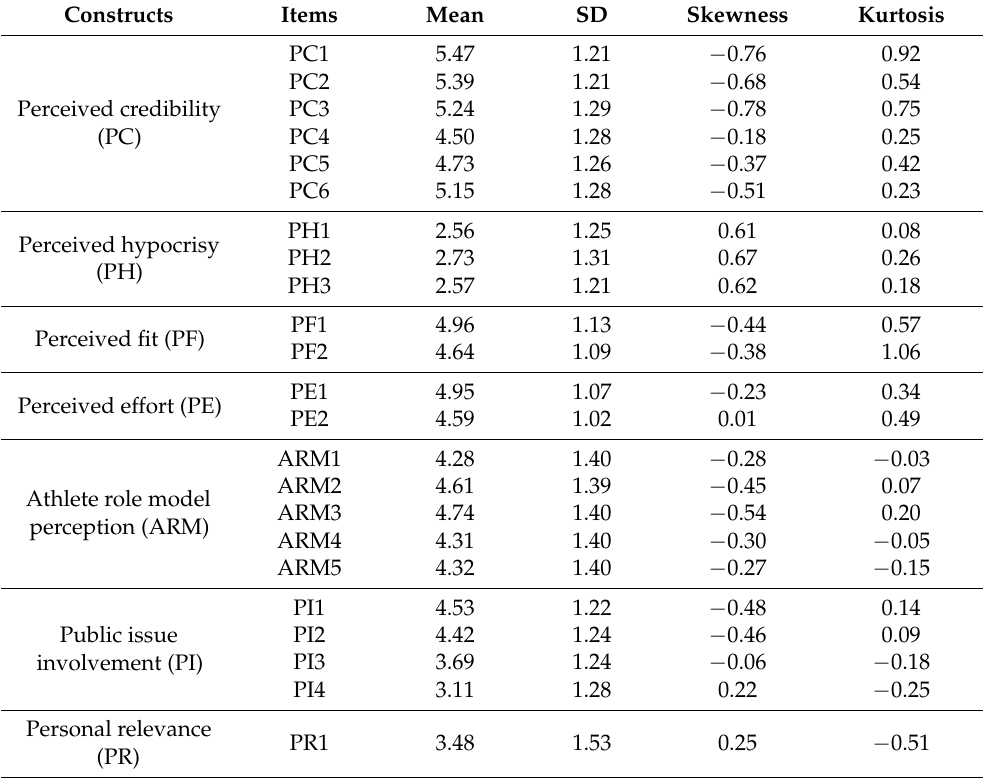
Table A1. Descriptive statistics (all sample: n =